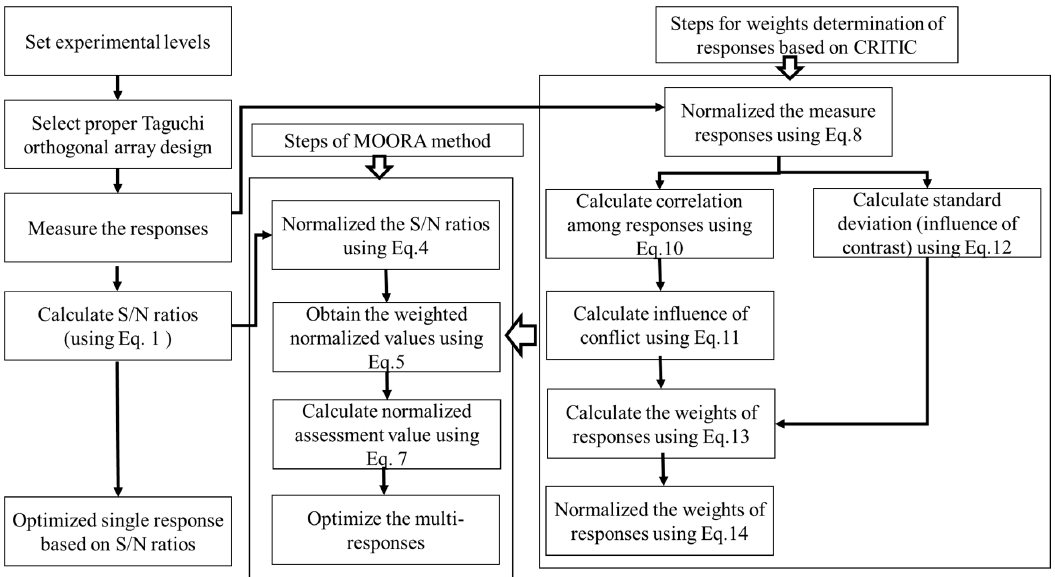
Figure 3. An optimization methodology for single and multi-responses. MOORA: multi-objective optimization on the basis of ratio analysis; CRITIC: criteria importance through inter-criteria correlation; S/N: Taguchi based signal to noise ratios.